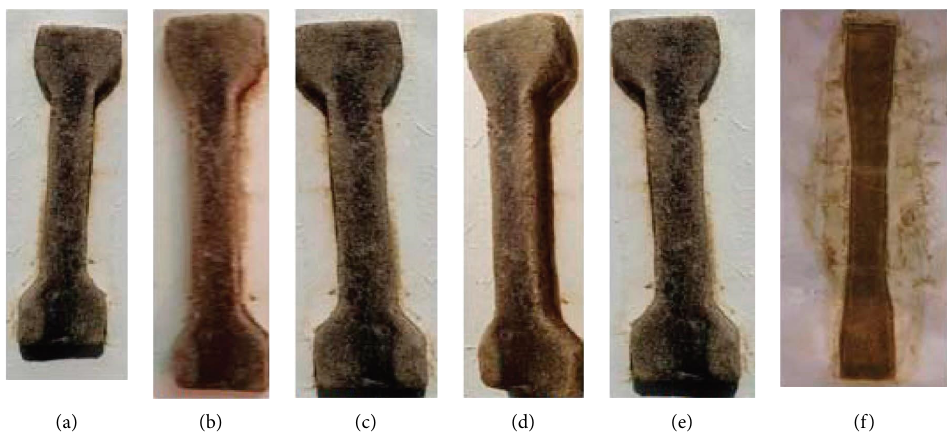
Figure 1: Specimen of PLA and rice bran composite with diferent ratios in wt. %: (a) 15/85. (b) 20/80. (c) 30/70. (d) 35/65. (e) 50/50. (f) Neat PLA.